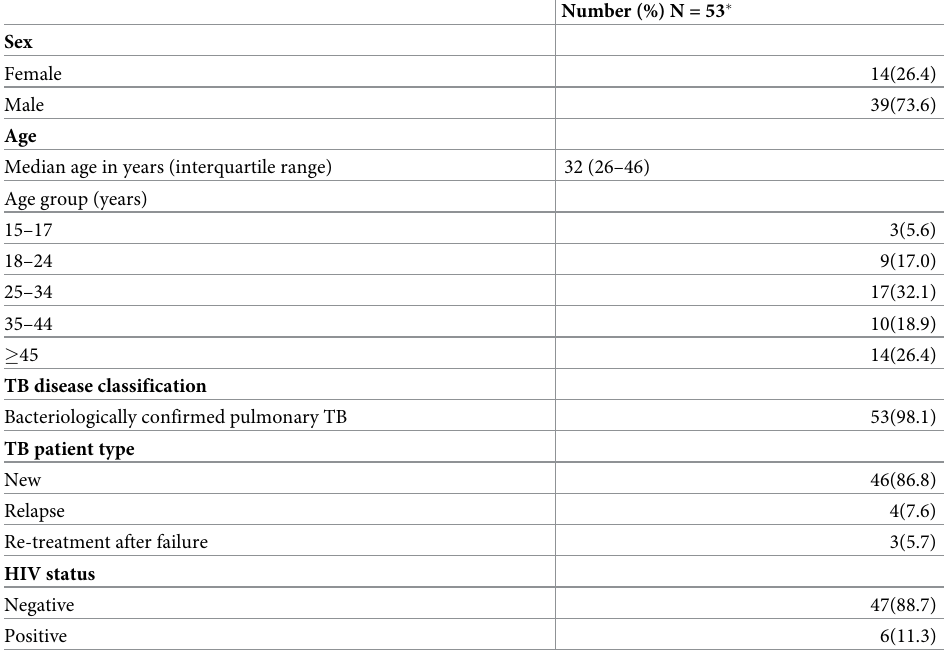
Table 4. TB index characteristics